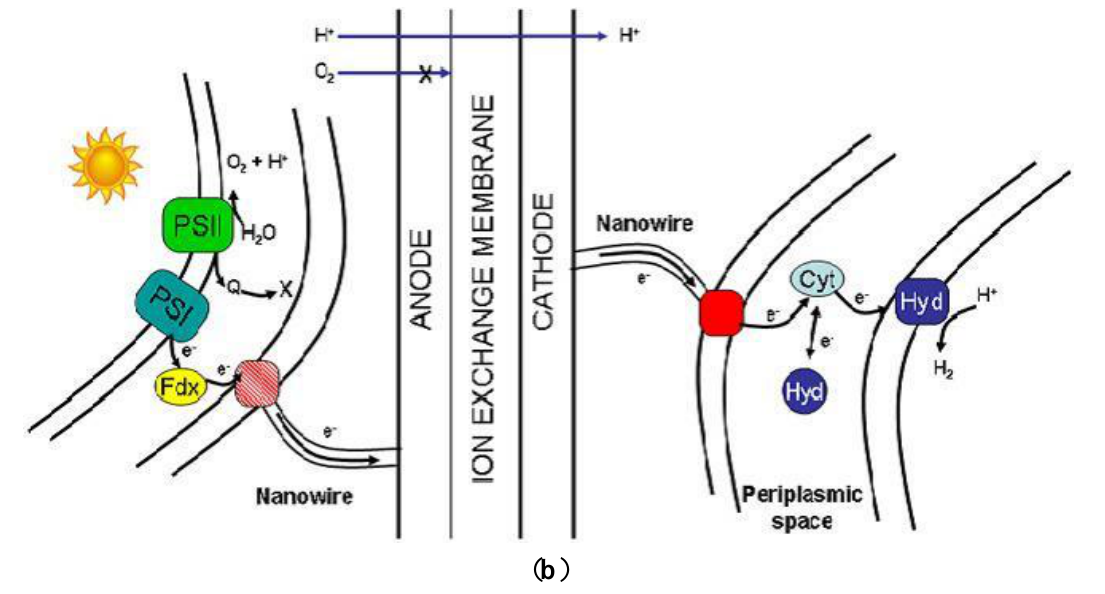
Figure 4. ( a ) Diagram of the PMEC. The cell is divided in two compartments by the ion-exchange membrane. The anodic and cathodic compartments contain the photosynthetic and heterotrophic microorganisms respectively. The electrical connectivity of the bacteria to the electrode is represented by the membrane bound proteins ( red dot ) and nanowires ( red line ); ( b ) Diagram representing a view of the bacteria/electrode interface. The red and pink squares represent the entry/exit point for the electrons while the cyan and yellow shapes represent the intermediate redox protein cytochrome Cyt —like in Desulfovibrio vulgaris bacteria or ferredoxin (Fd) enzymes pool,